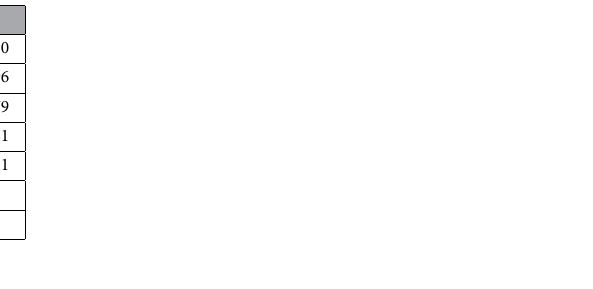
Table 4. Warpage range analysis.